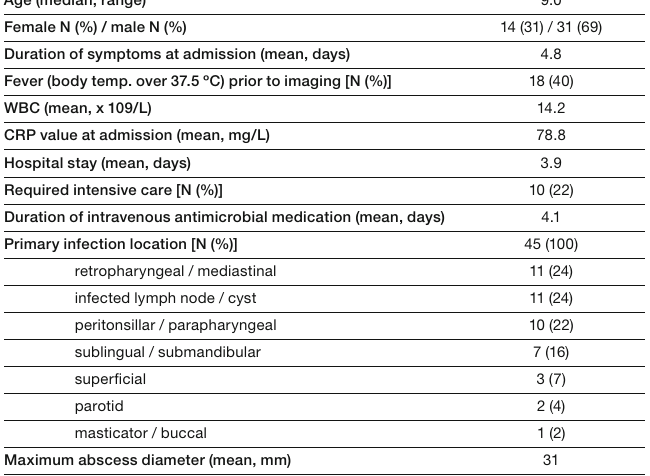
Keywords: carotid blow out, embolization, endovascular treatment Short summary: Carotid blowout syndrome (CBS) can be a life-threatening